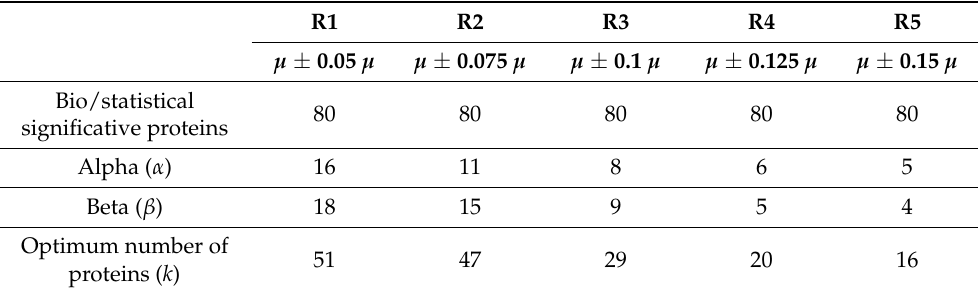
Table 3. Optimum values obtained for the α , β - k -feature set